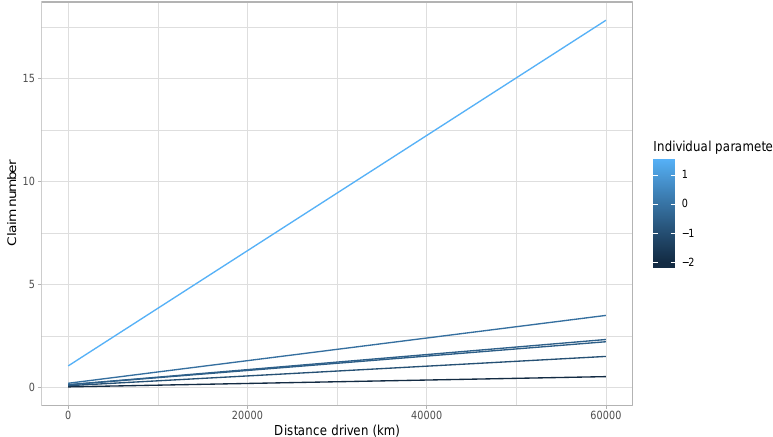
Figure 13. Exposure measure for different individual